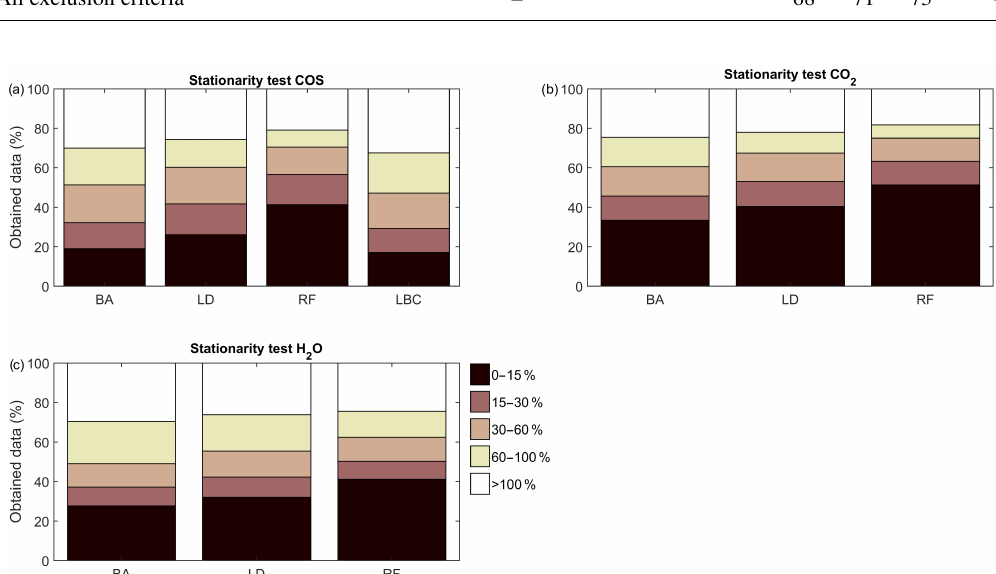
Figure 5. Stationarity test after Foken and Wichura (1996) for COS (a) , CO 2 (b) and H 2 O (c) fluxes calculated for different high-pass filtering scenarios: block averaging (BA), linear detrending (LD), recursive filtering (RF) and linear background correction (LBC; COS only). The colour coding refers to percentage deviations from perfect stationarity (Foken and Wichura,